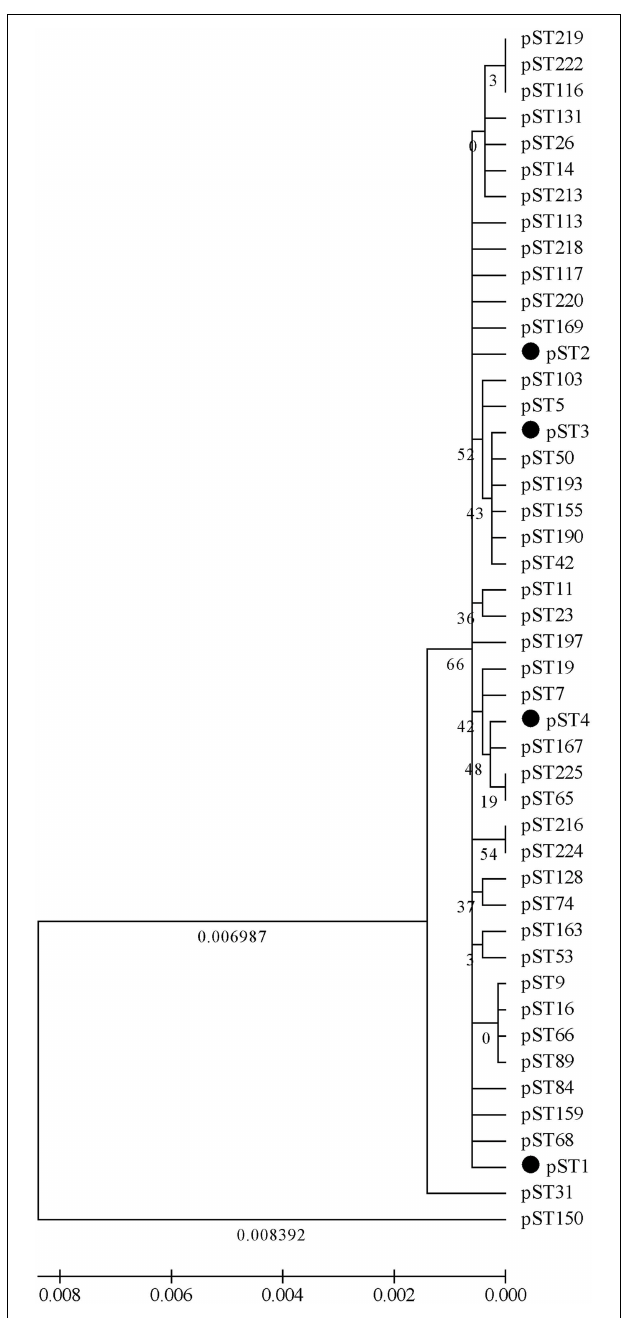
FIGURE 4 | A ME tree was constructed using the concatenated peptide sequences of the 46 pSTs. Bootstrap values over 50% and the branch lengths (evolutionary distances) over 0.005 are shown in the figure.